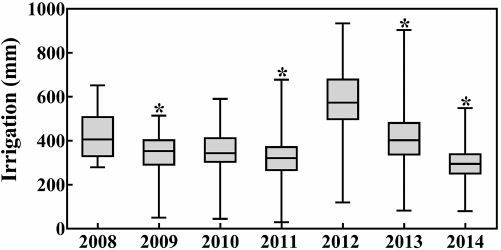
Figure 4. Box and whisker plots of historical irrigation depths for all sites. The upper and lower boundaries of the boxes indicate the 75th and 25th percentile, respectively. The horizontal line within the boxes is the median value. Whiskers are the maximum and min- imum values. Asterisks indicate that irrigation distribution deviates from a normal distribution (D’Agostino–Pearson test, p <